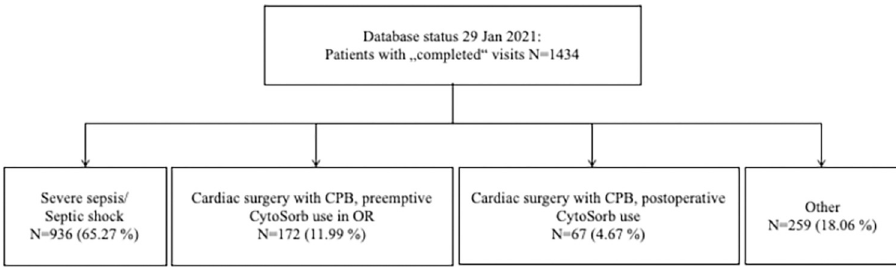
Fig 1. The number of patients by indication. CBP, cardio-pulmonary bypass, OR operating room.